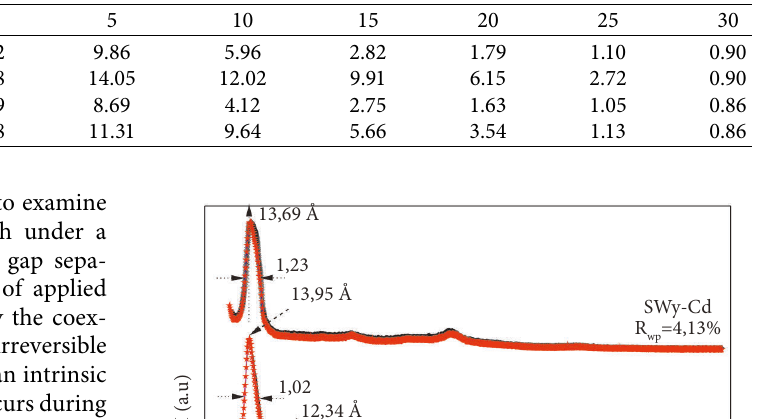
Table 1: Equilibrium void ratio e for the compaction and reswelling data for SWy-Co and SWy-Cd samples. Zero bar corresponds to “free” swelling.